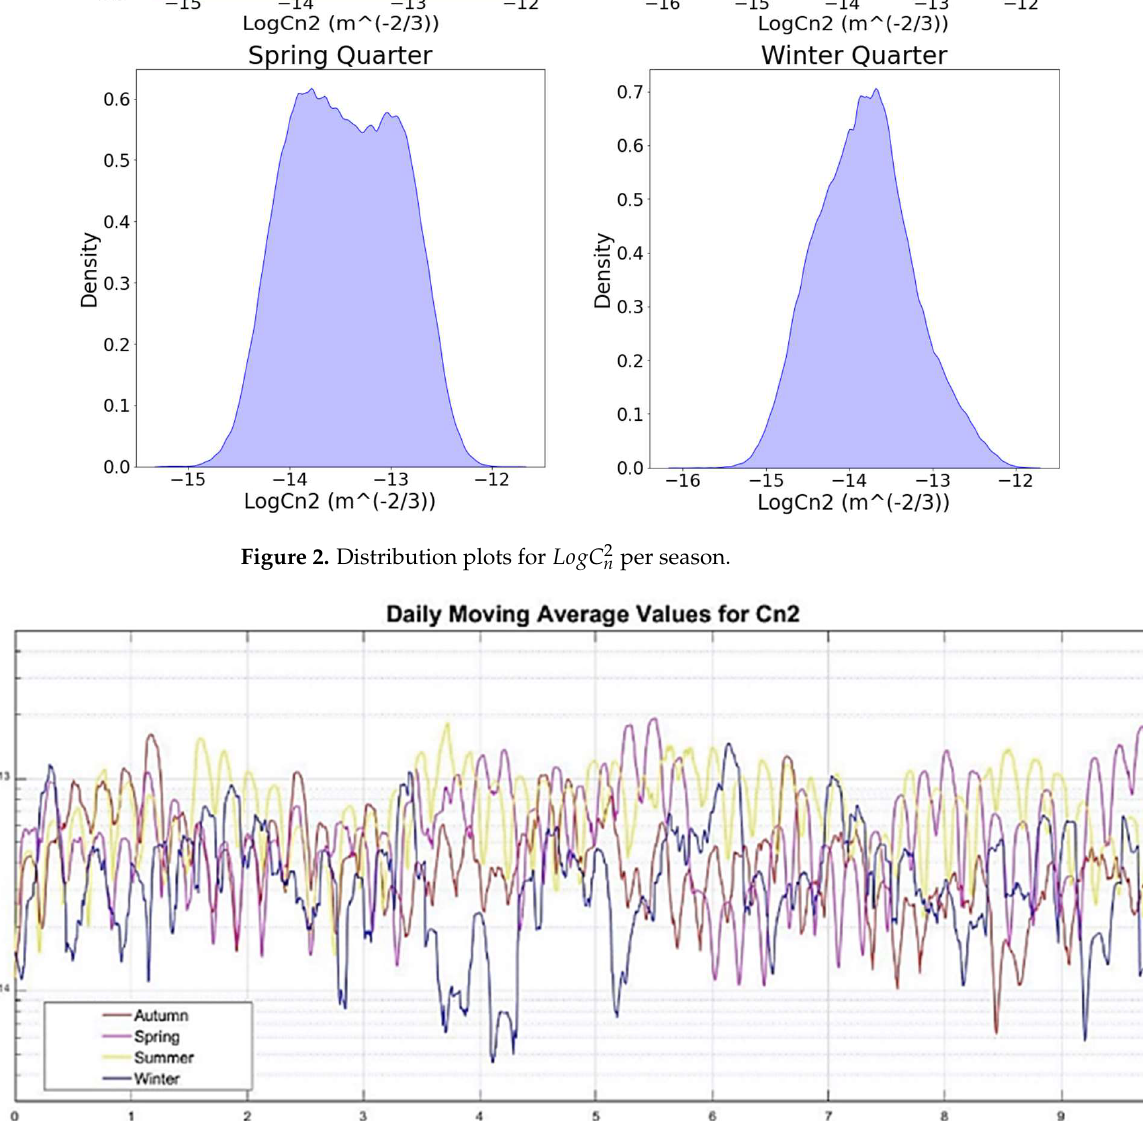
Figure 3. The daily moving average of the C 2 n for every season.